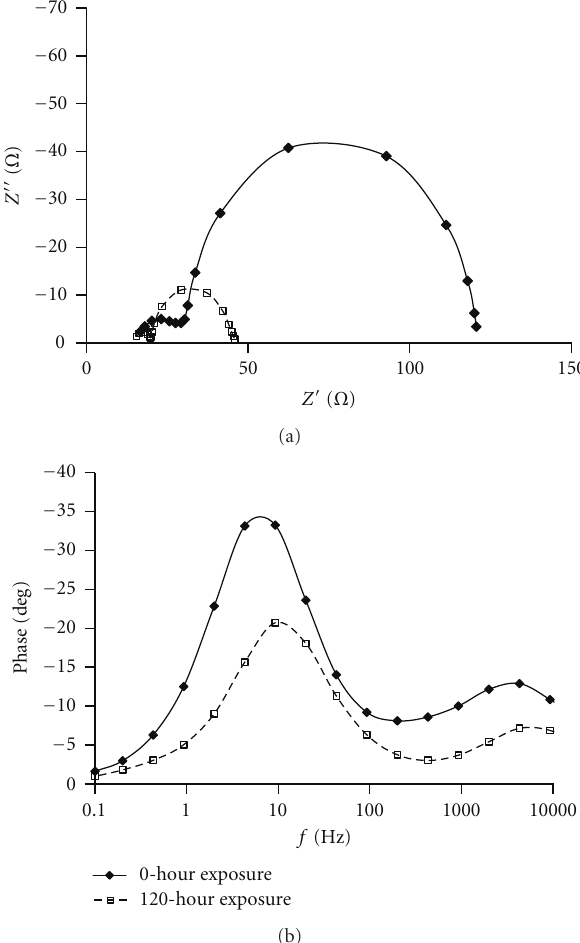
Figure 3: Nyquist plot (a) and Bode phase diagram (b) of the same cell as in Figure 2. These results are typical of all the cells exposed during this